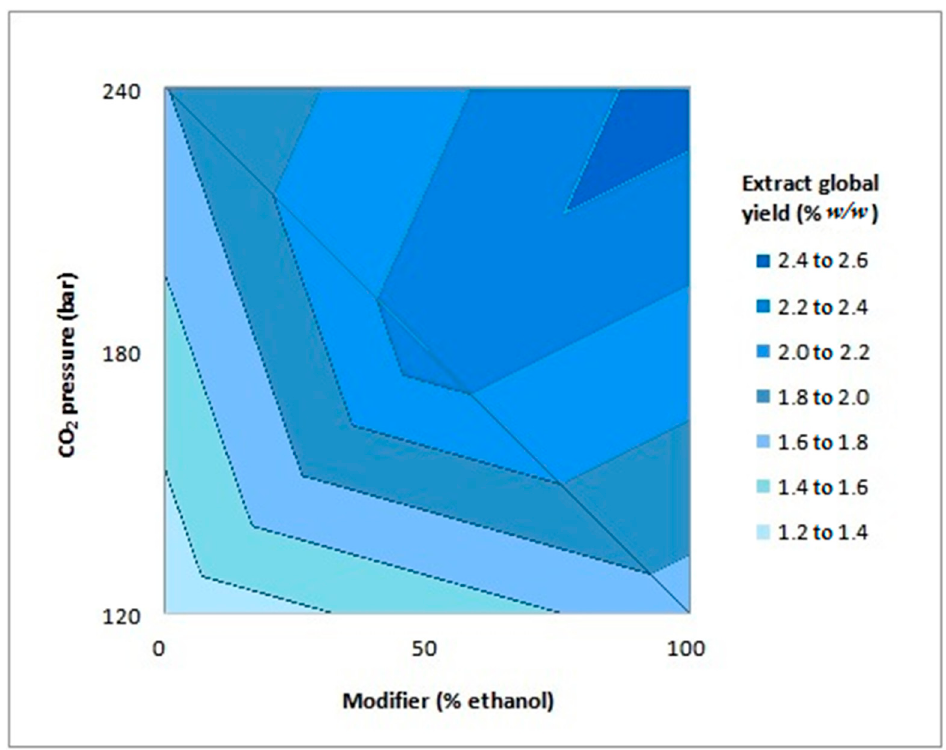
Figure 1. Contour plot for global extraction yield as a function of CO 2 pressure and modifier. The model fitted to the experimental data was presented as a coefficient of determination, R², which was equal to 0.9981. The adjusted coefficient of determination had a value of 0.9944, which means that only 0.56% of the variations were not explained by the model used for the contour plot, which is presented in Equation (1): (cid:1875) (cid:1859)(cid:1864)(cid:1867)(cid:1854)(cid:1853)(cid:1864) (cid:1877)(cid:1861)(cid:1857)(cid:1864)(cid:1856) (cid:4672) % (cid:1875)(cid:4673) (cid:3404) 1.81281 (cid:3397) 0.32906 P (cid:3397) 0.29094 M (cid:3397) 0.06094 P M where P is the pressure and M is the modifier (values for coded variables).